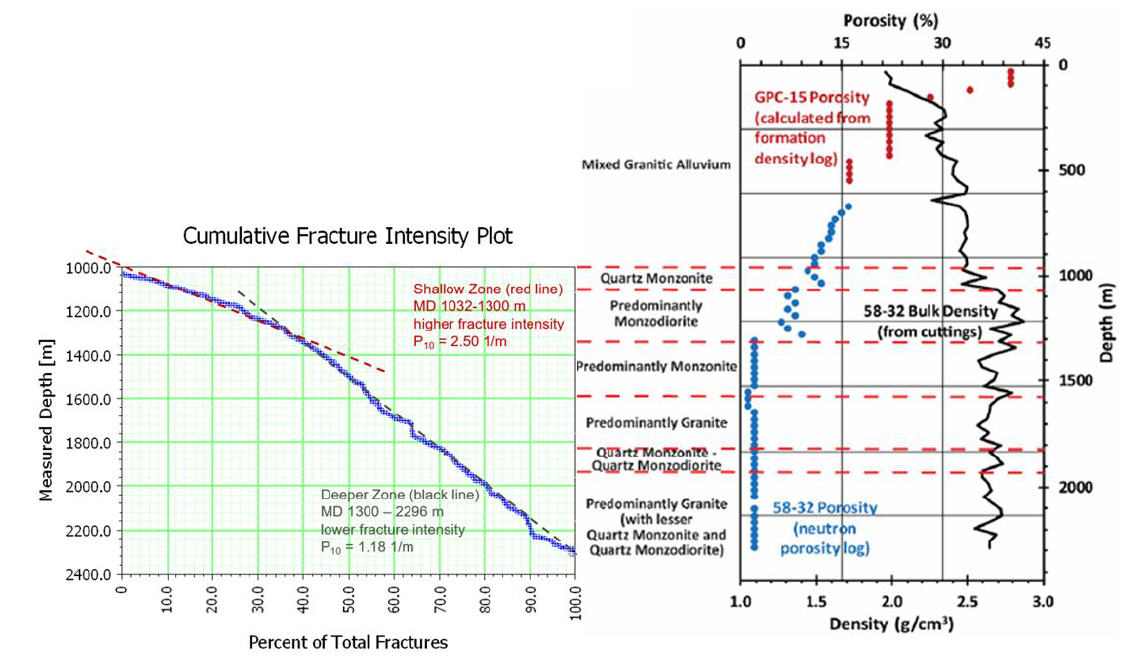
Figure 6. Depth aligned CFI plot of 58-32 FMI fractures in granitoid on the left and measured density values from drill cuttings at 100-foot intervals in Well 58-32 on the right, adapted from